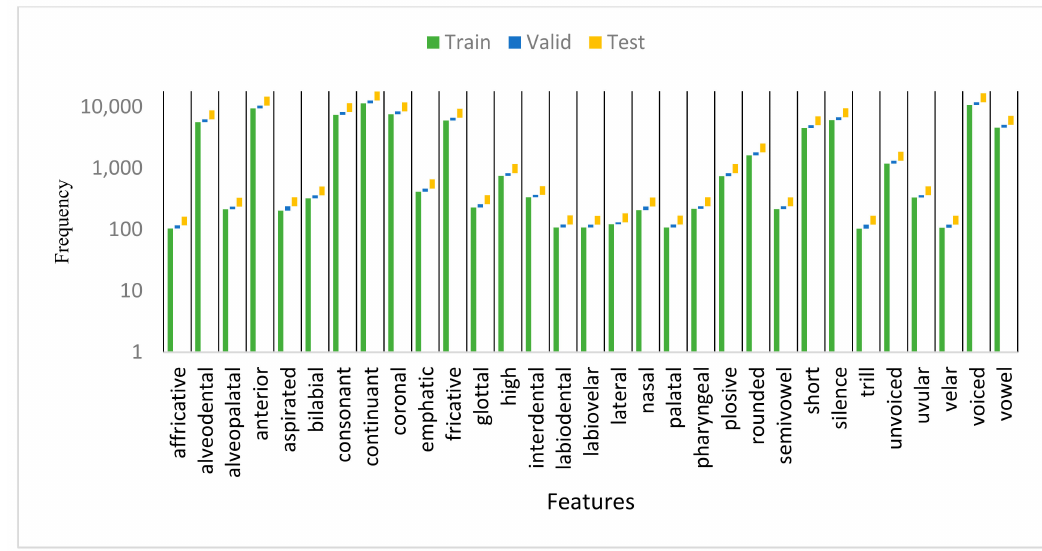
Figure 3. Occurrences of AF classes on the training, validation, and testing sets of KAPD.